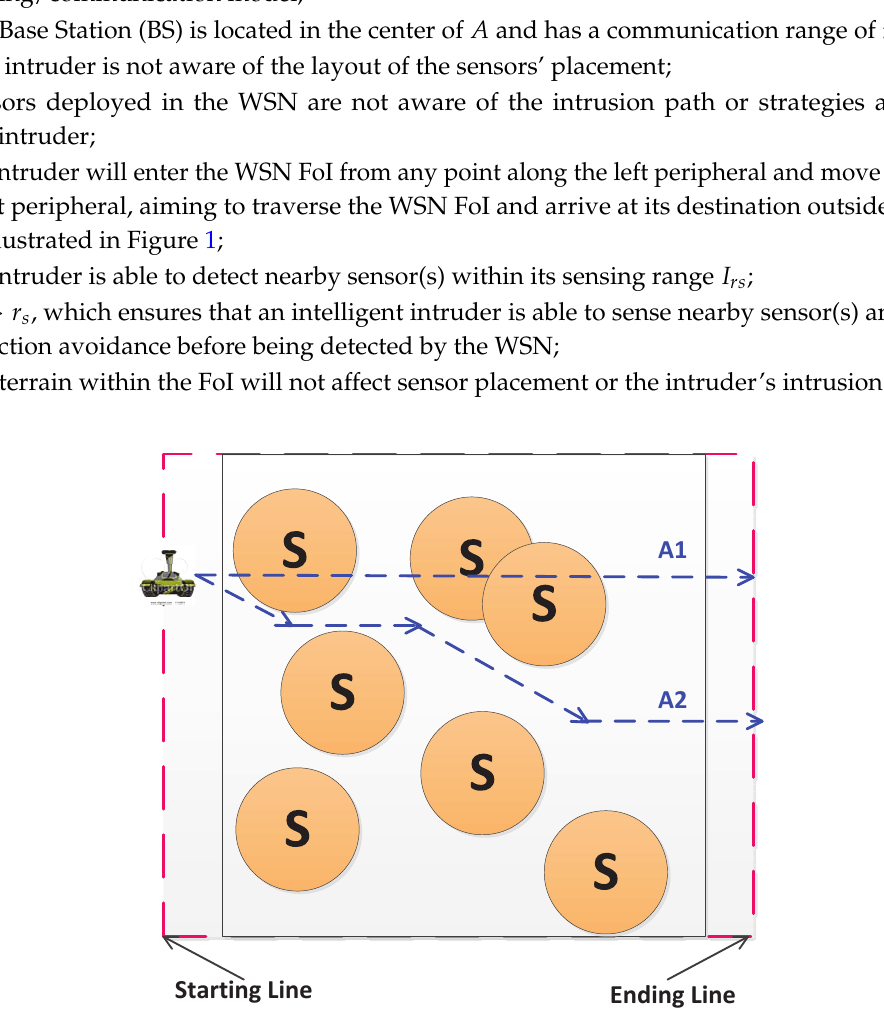
Figure 1. Illustration of an intelligent intruder detection problem formulation in a WSN. The intruder starts from a random point on the imaginary left periphery and moves toward another random point on the imaginary right periphery, which is the intruder’s destination. The intruder may adopt an AI-enabled intrusion algorithm (like A 2 ) for detection